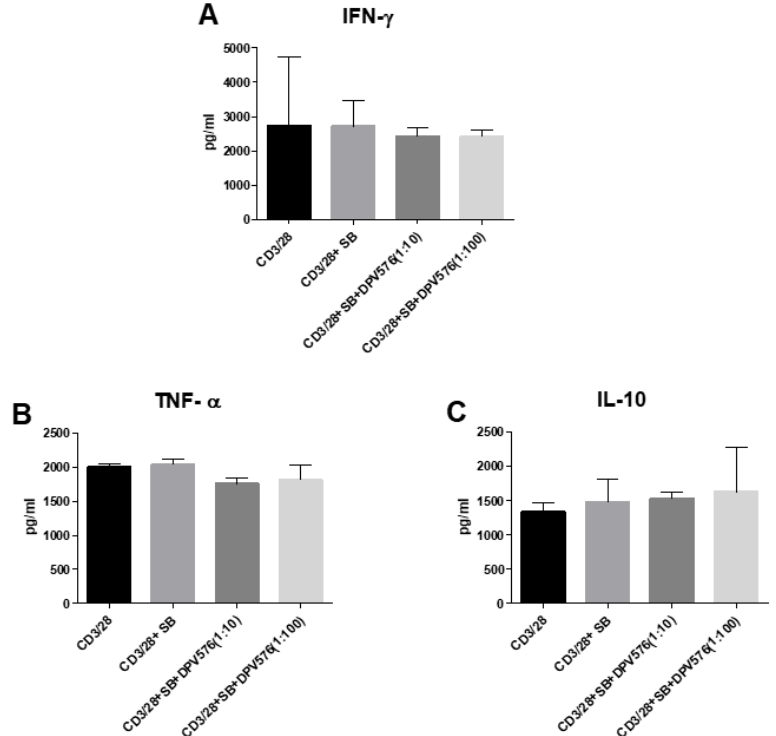
Figure 4. ( A – C ) TRPV1 antagonist, SB366791 (SB), inhibits the effect of DPV576 on cytokine secretion by CD4 + T cells. SB + anti CD3/CD28 activated CD4 + T lymphocytes were exposed to DPV576 for 24 h. Secretion of cytokines was determined by ELISA. Bar graph depicts the level of: ( A ) IFN- γ , ( B ) TNF- α , and ( C ) IL-10. Data is mean ± S.E. of three experiments. 3.5. DPV576 Synergizes with Capsaicin to Downregulate the Expression of TRPV1 on CD4 + T Cells To investigate the effect of DPV576 on the TRPV1 agonist, capsaicin-induced TRPV1 activity, we determined the expression of TRPV1 on anti-CD3 and anti-CD28 activated CD4 + T cells stimulated with capsaicin in the presence or absence of DPV576. Results of flow cytometry suggest that capsaicin downregulated the expression of TRPV1 on CD4 + T cells, which is further downregulated in the presence of DPV576 (Figure 5A,B). Thus, DPV576 synergizes with capsaicin to desensitize TRPV1.